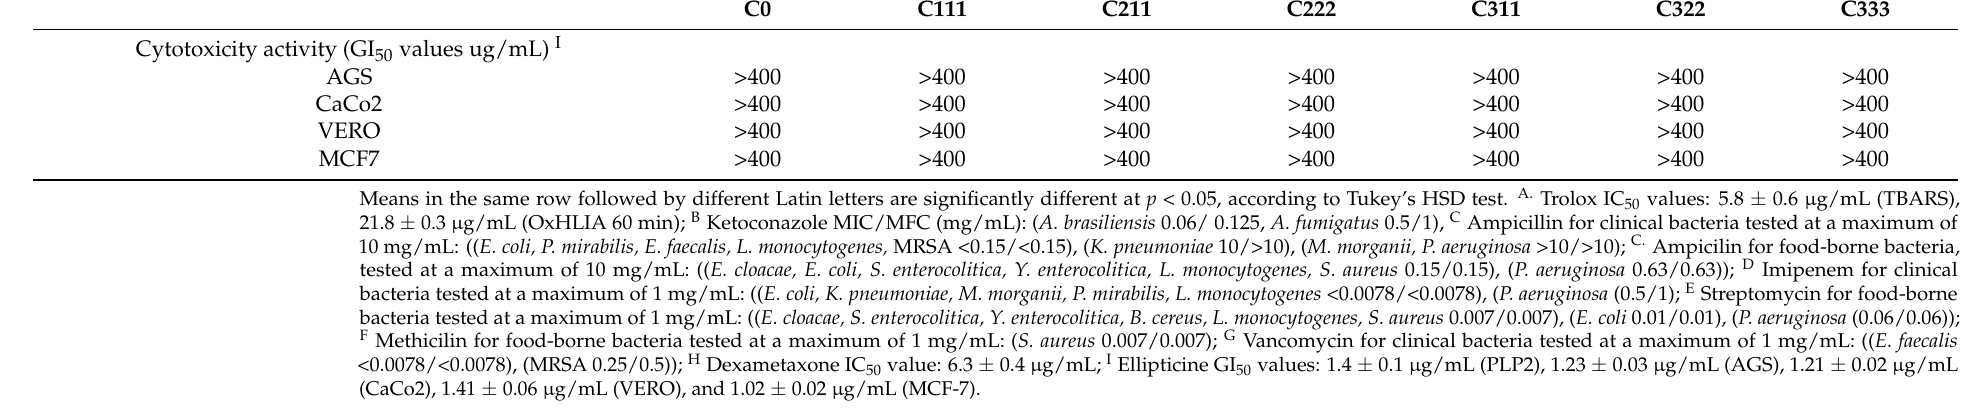
Table 8. Antioxidant, antimicrobial, anti-inflammatory, hepatotoxic, and cytotoxic activities of the aqueous extract of C. spinosum (mean ± SD). C0